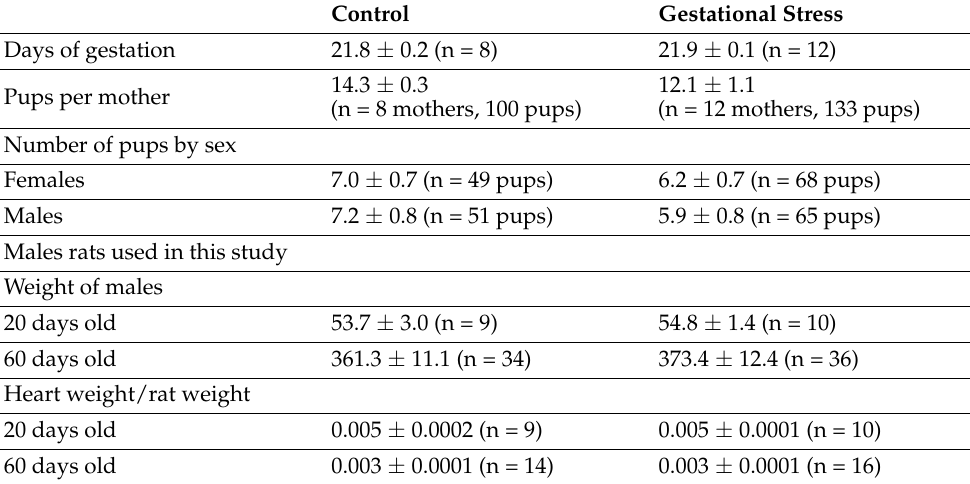
Table 1. General characteristics of the progeny obtained after gestational stress. The number of male rat progeny used for the present work either at 20 or 60 days old according to Figure 1 is shown. The number of 9 or 10 rats at 20 days old considers two series: one was the control with 4 rats, and the other was the progeny of 5 stressed rats. The increased number at 60 days old was due to the groups of control treated with ISO or with saline. Results represent mean values ± SEM with the total n for each group in